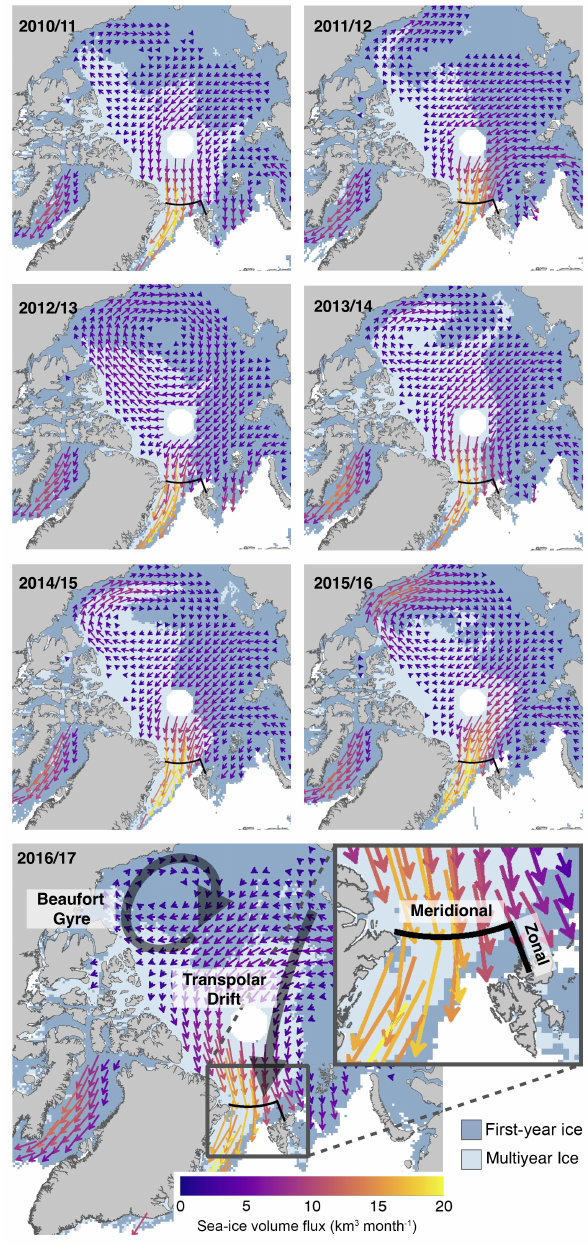
Figure 1. Averages of Arctic sea ice volume fluxes for 2010– 2011 and 2016–2017 between October and April. The enlarged box shows the location of the Fram Strait gate at 82 ◦ N, which is used for the calculation of the export rates, separated into meridional and zonal